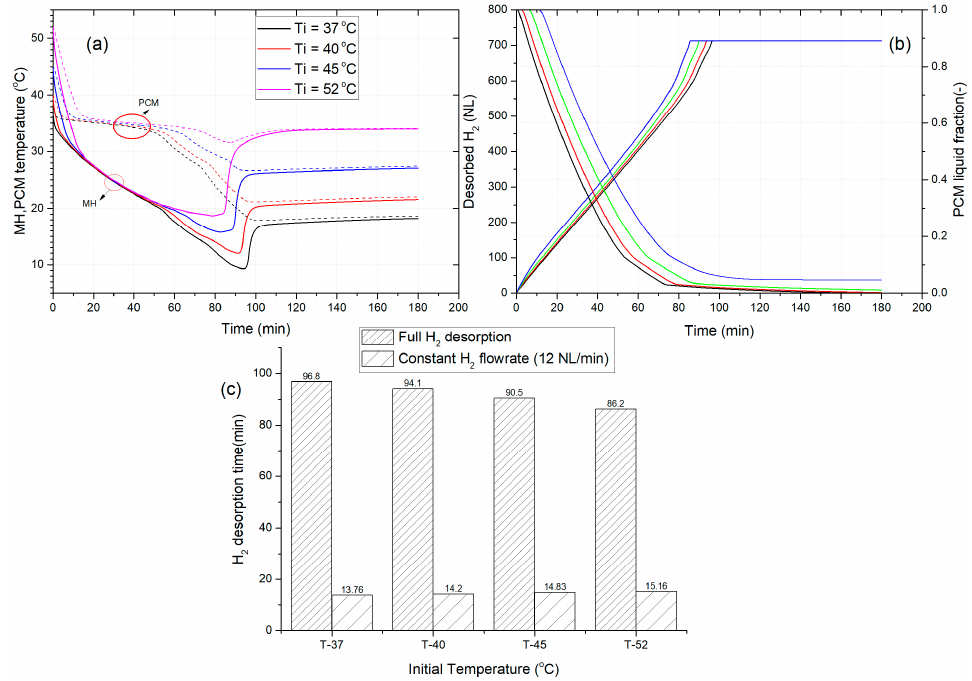
Figure 6. The effect of initial temperature ( a ) temporal variation of the average MH and PCM temperature, ( b ) temporal profile of PCM liquid fraction and the H 2 volume desorbed, and ( c ) dehydrogenation time.